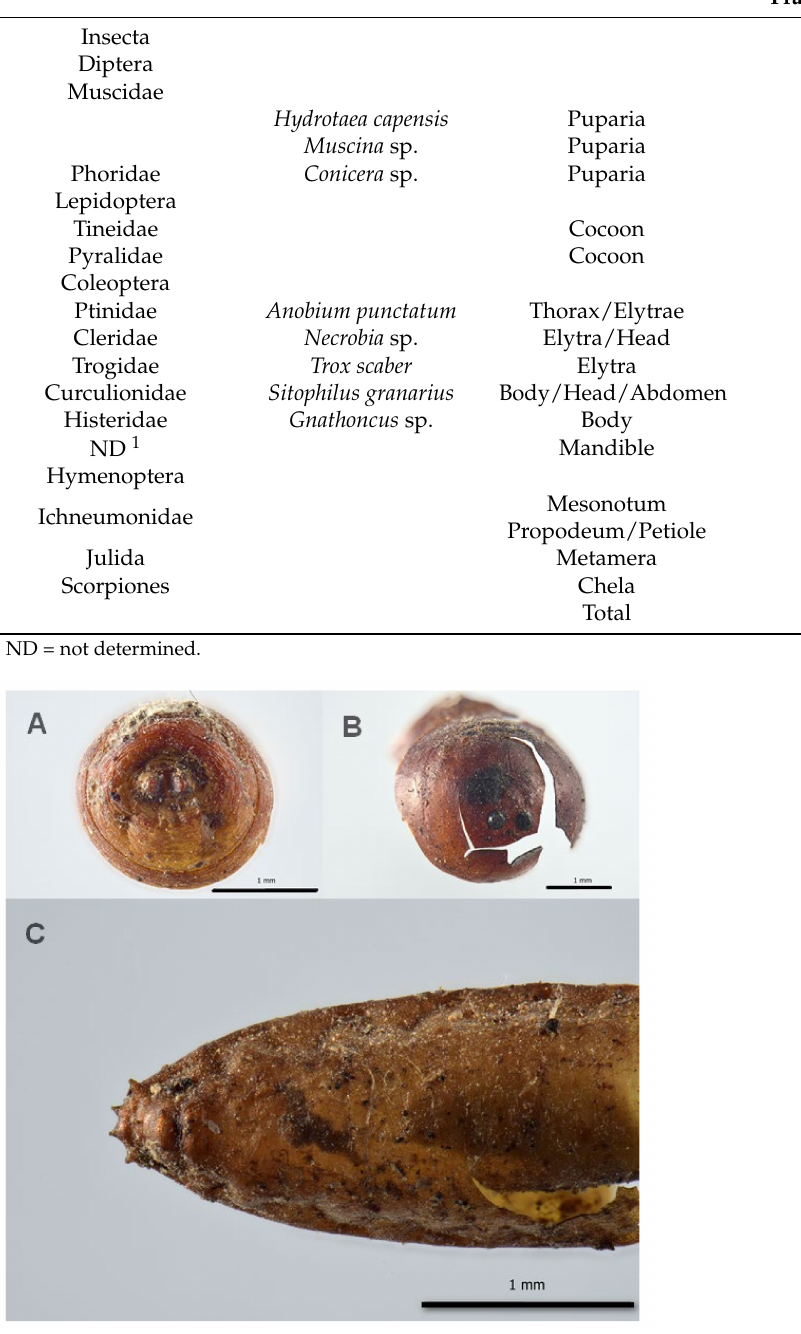
Figure 2. Diptera remains associated to the burial site of Saint Davino Armeno: ( A ) Hydrotaea capensis , puparia, posterior spiracles; ( B ) Muscina sp., puparia, posterior spiracles; ( C ) Conicera sp., puparia, posterior